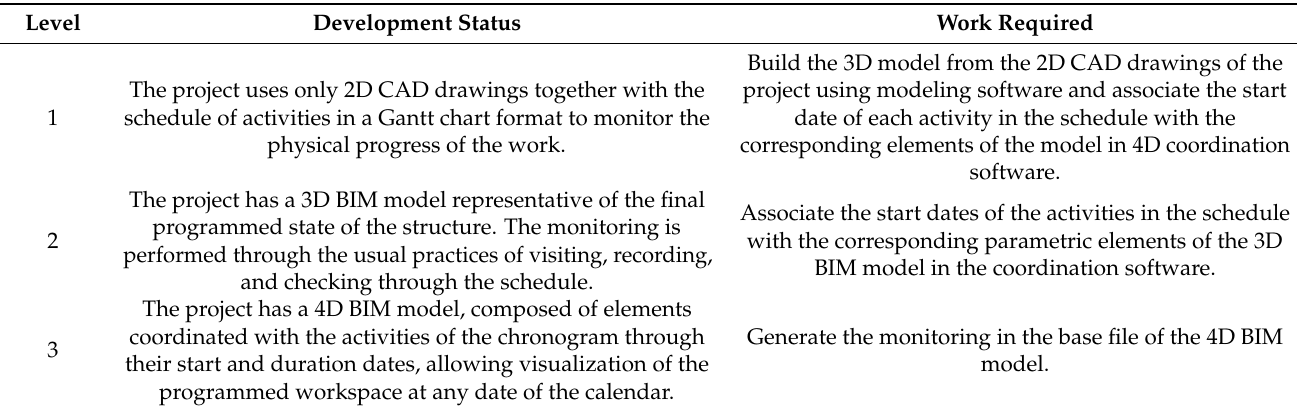
Table 1. Modeling work required for the implementation of the proposed methodology.